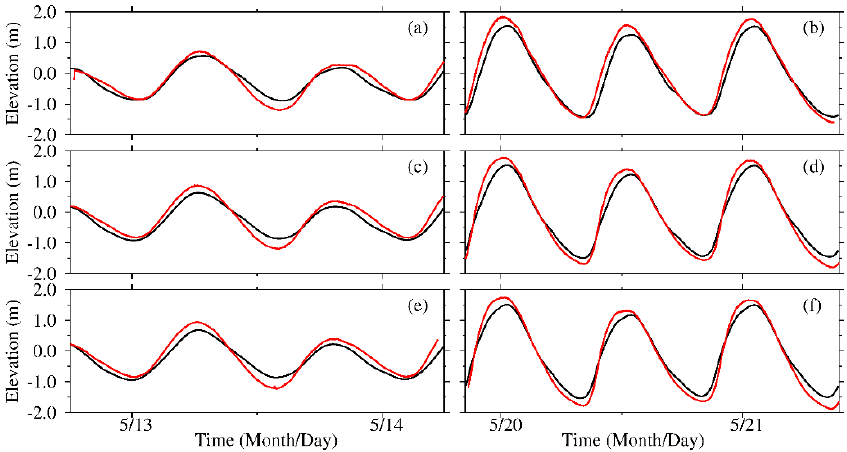
Figure 5. Comparison between the modeled (black) and observed (red) elevations at measurement sites A ( a , b ), B ( c , d ) and C ( e , f ) during the neap tide (left panels) and the spring tide (right